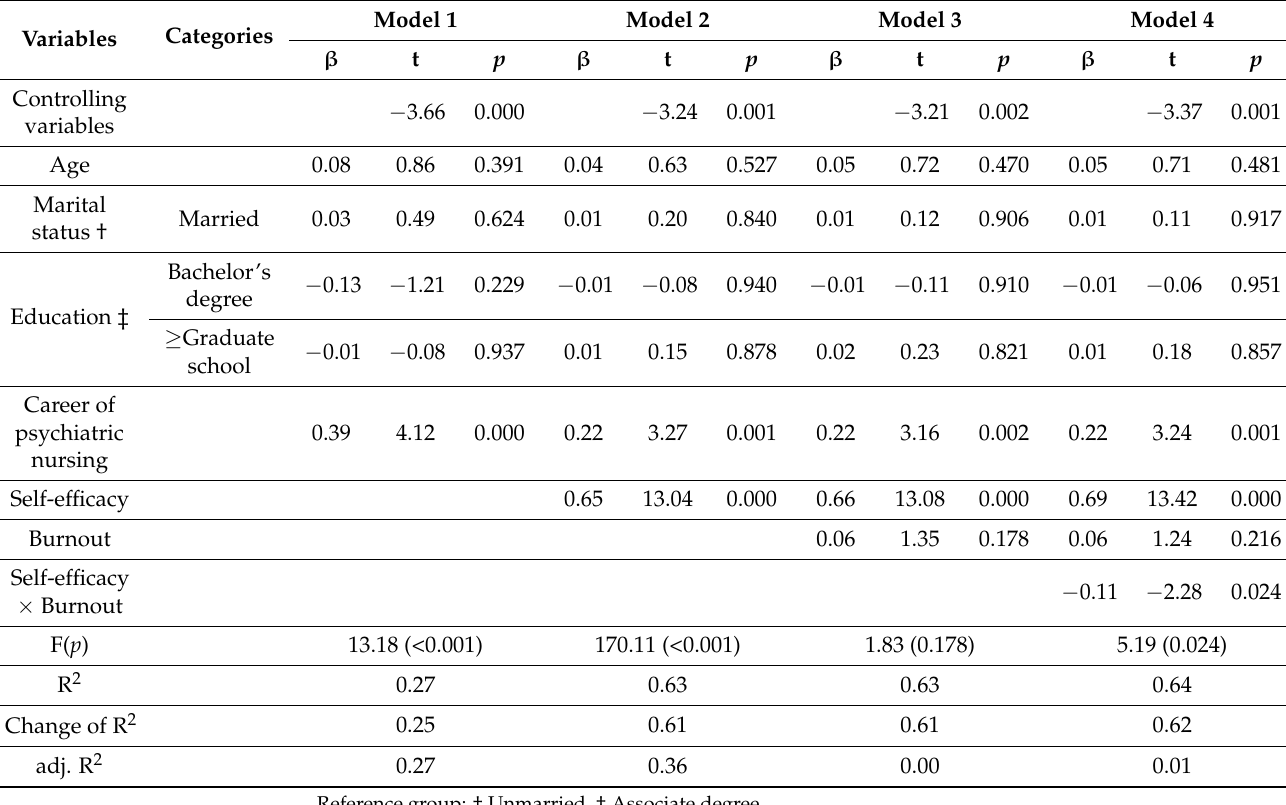
Table 4. Moderating effect of burnout on the relationship between self-efficacy and job performance ( n = 186).